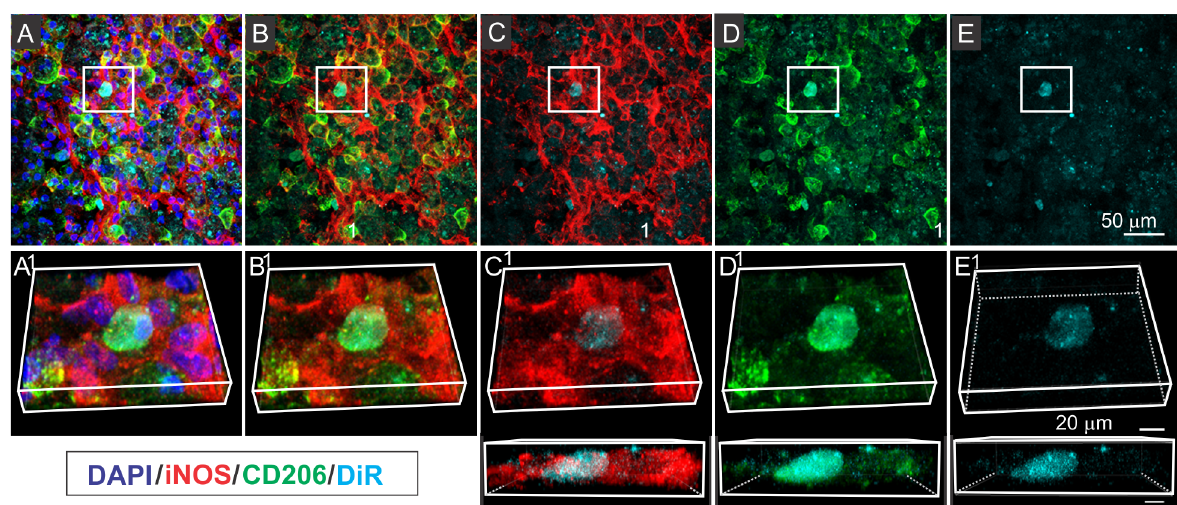
Fig 5. IV infused DiR labeled MSC exos localize with CD206 + Type M2 macrophages in the contused spinal cord. A-E Confocal micrographs of a representative region of a frozen sectioned contused spinal cord harvested 24 hours after IV infusion of DiR labeled exosomes (cyan), immunostained with antibodies directed against Type M1 macrophage marker iNOS (red) and Type M2 macrophage marker CD206 (green) and counterstained with DAPI (blue). Images from left to right show the same area showing florescence channels for (A) iNOS, CD206, DAPI, & DiR, (B) iNOS, CD206, & DiR (C) iNOS, & DiR, (D) CD206, & DiR, and (E) DiR only. Images in a-e show enlarged images of boxed area above rotated and illustrated in 3D. A smaller portion of the regions shown in c-e is further enlarged and rotated below. Note the strong co-localization of DiR florescence with CD206, but not iNOS staining, suggesting that DiR labeled exosomes are taken up by Type 2 macrophages. Scale bars in E and e & d indicate 50 μ m and 20 μ m and apply to A-E and a-e respectively.